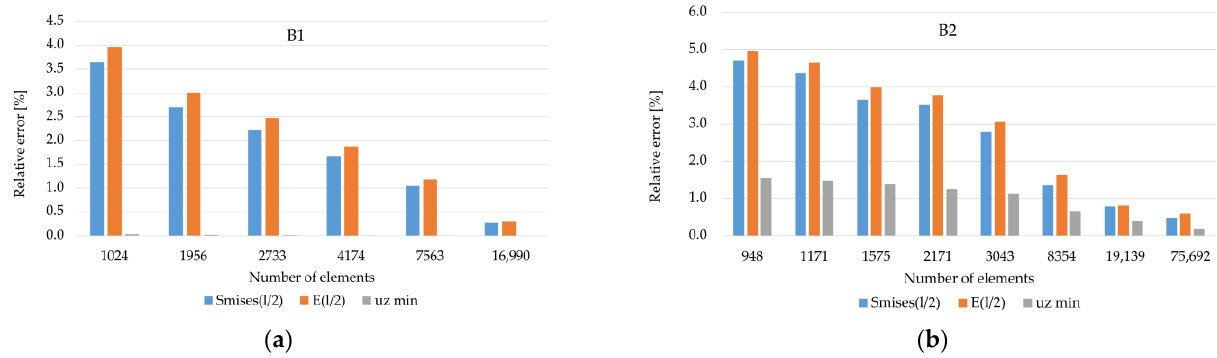
Figure 8. Relative error of individual quantities in relation to the approximated “reference” solution: ( a ) variant B1; ( b ) variant B2.